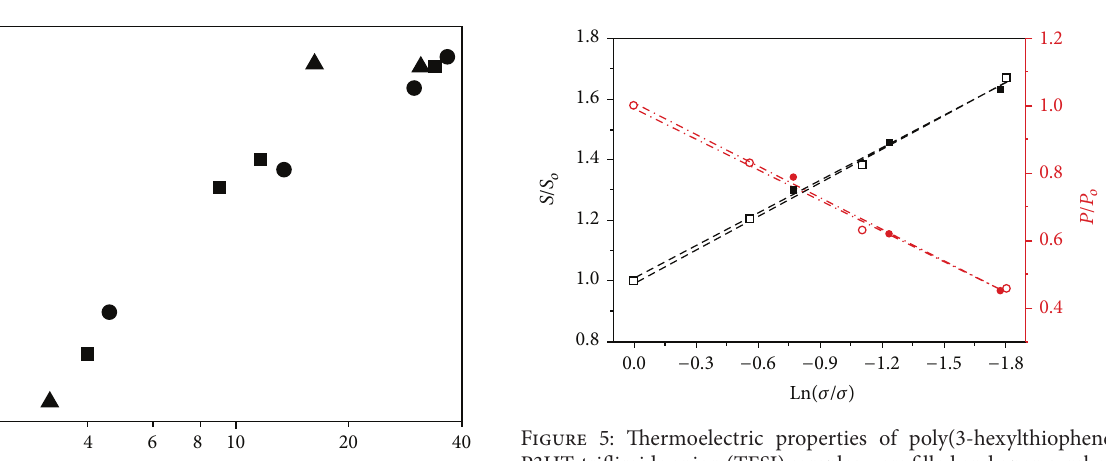
to result in high electrical conductivity. However, this also causes a corresponding decrease in the Seebeck coefficient.